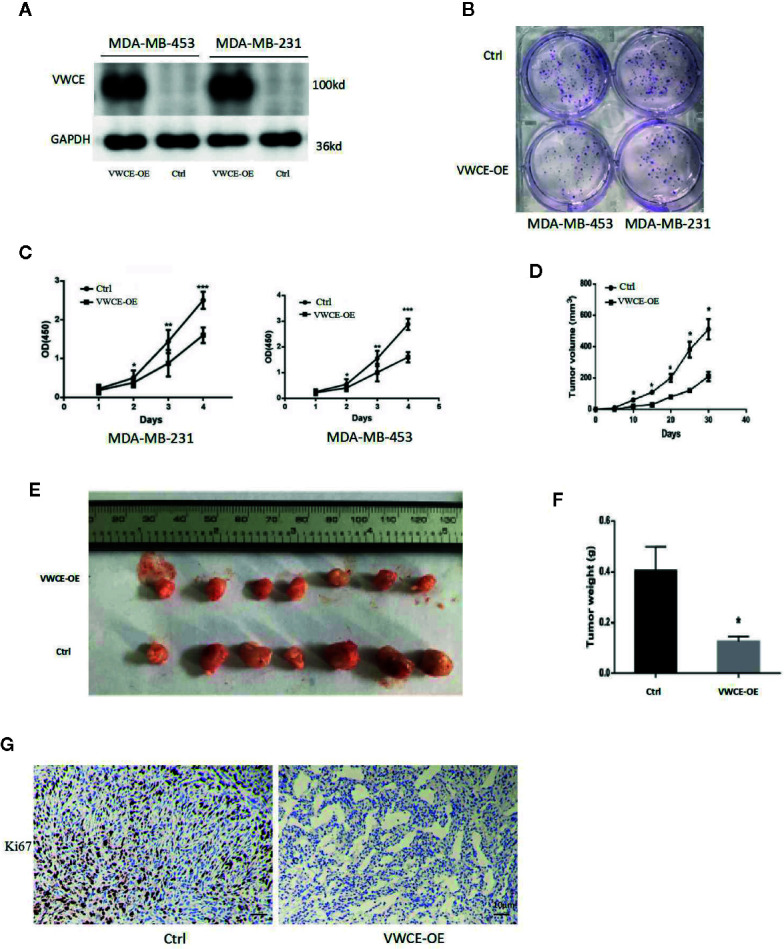
Von Willebrand factor C and EGF domain (VWCE) inhibits breast cancer cell proliferation. (A) Western blot analysis of VWCE protein expression in MDA-MB-453 and MDA-MB-231 cells stably transfected with a VWCE-overexpressing or negative control lentivirus. GAPDH was used as a loading control. (B) A plate cell colony formation assay of the ectopic expression of VWCE on MDA-MB-453 and MDA-MB-231 cells. (C) CCK8 analysis of the effects of the ectopic expression of VWCE on the proliferation of MDA-MB-453 and MDA-MB-231 cells. Experiments were performed in triplicate and data are presented as means ± standard deviations; *p < 0.05, **p < 0.01, and ***p < 0.001, compared to the control, respectively. (D) The tumor growth curves were measured after a subcutaneous injection of the MDA-MB-231-Control and MDA-MB-231-VWCE. The tumor volume was calculated every five days. Error bars indicate standard deviation (Student’s t-test; *P < 0.05; n = 5). (E) Photographs of the dissected tumors from nude mice. (F) The weight of tumors from mice with MDA-MB-231-Control and MDA-MB-231-VWCE implantation. Error bars indicate standard deviation (Student’s t-test; *P < 0.05, n = 5). (G) Cellular proliferation in VWCE-expressing vs. control tumors. Paraffin-embedded tissue sections of the primary tumors from mice injected with MDA-MB-231-Control and MDA-MB-231-VWCE cells were immunostained with an anti-Ki67 antibody. Photomicrographs were taken at 20× magnification; scale bars = 10 μM.